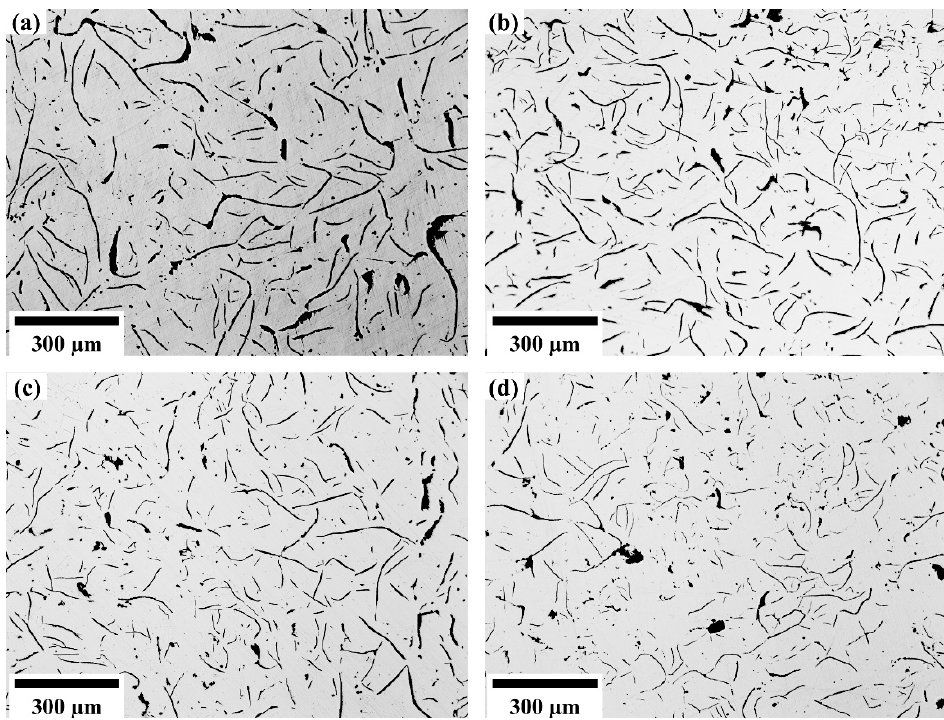
Figure 8. The graphite structure with different niobium content. ( a ) 0% Nb; ( b ) 0.098% Nb; ( c ) 0.27% Nb; ( d ) 0.46% Nb.